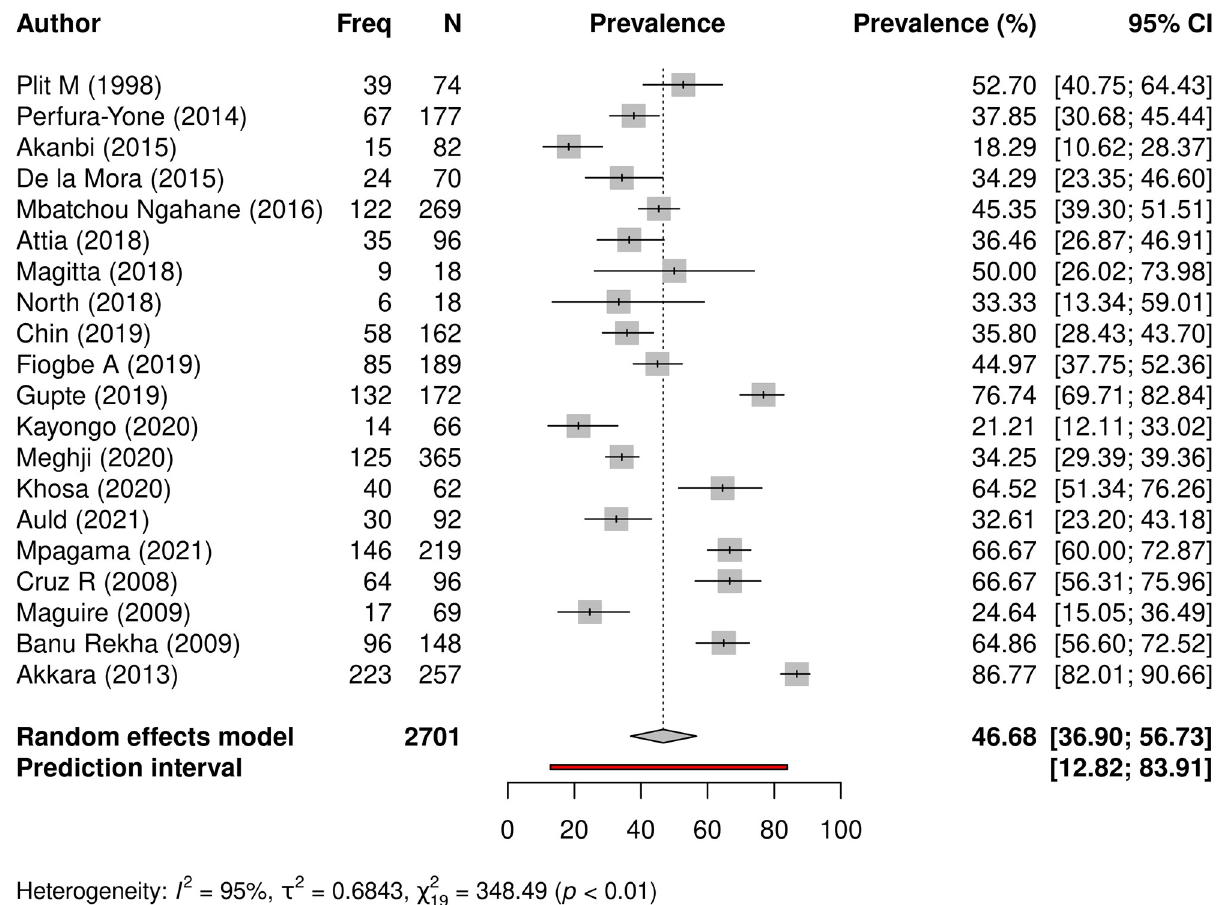
Fig 2. Prevalence of abnormal lung function following TB. A forest plot showing individual study prevalence and pooled prevalence of residual impairment of lung function in 20 studies that conducted spirometry in a pooled sample size of 2701 study participants post-TB.